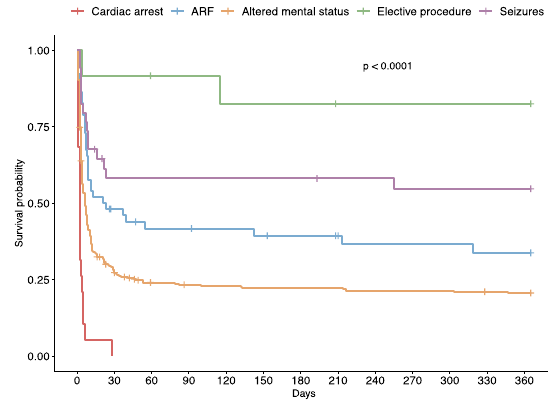
Fig. 1 Kaplan–Meier’s survival estimates of patients according to the reason for endotracheal